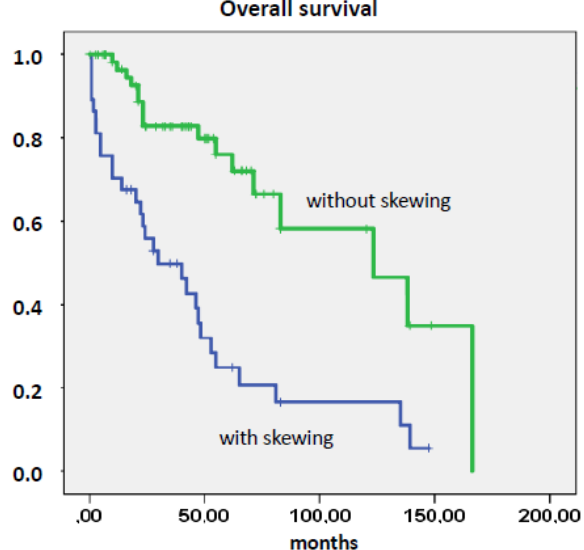
Figure 5. Overall survival of myelofibrosis patients stratified by the presence or absence of myelomonocytic skewing. Table 2. Univariate analysis of single prognostic parameters in patients with myelofibrosis. Factors